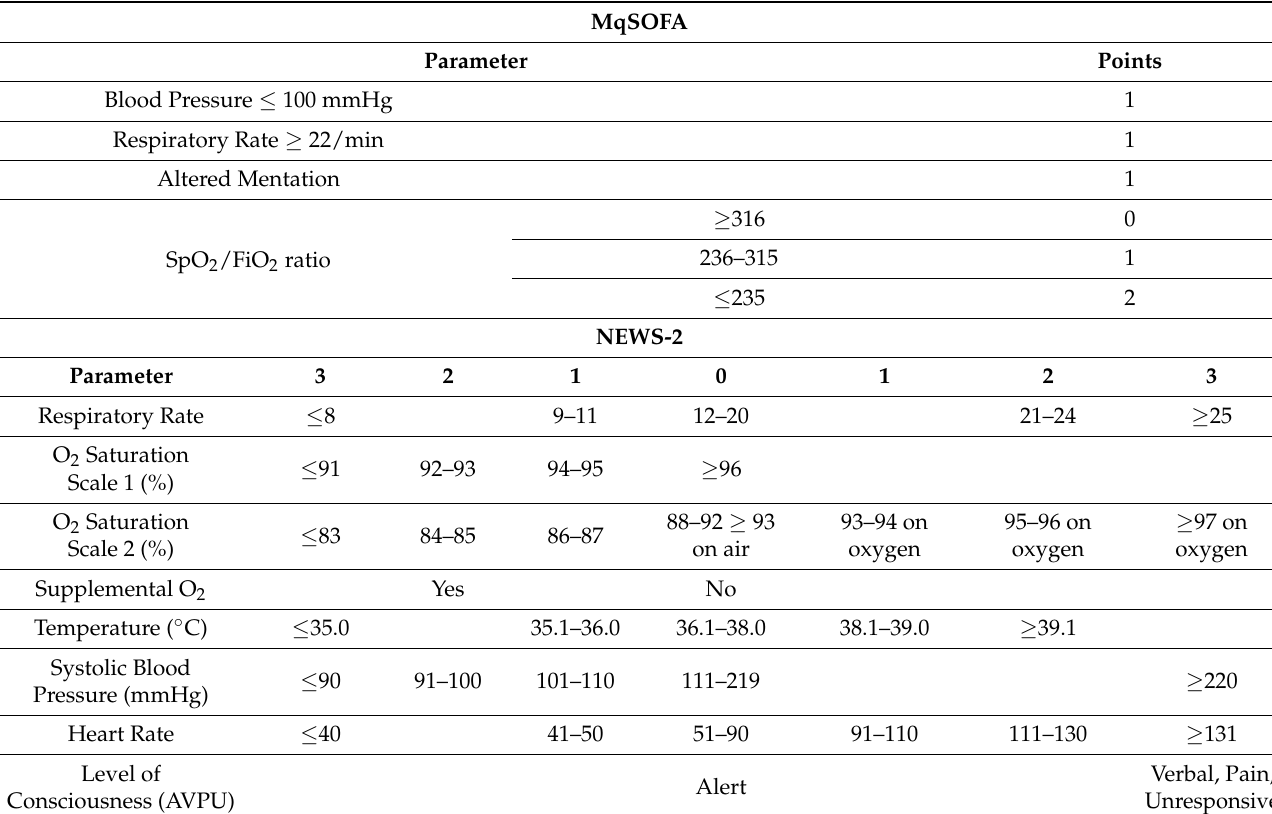
Table 1. Comparison between MqSOFA and NEWS-2